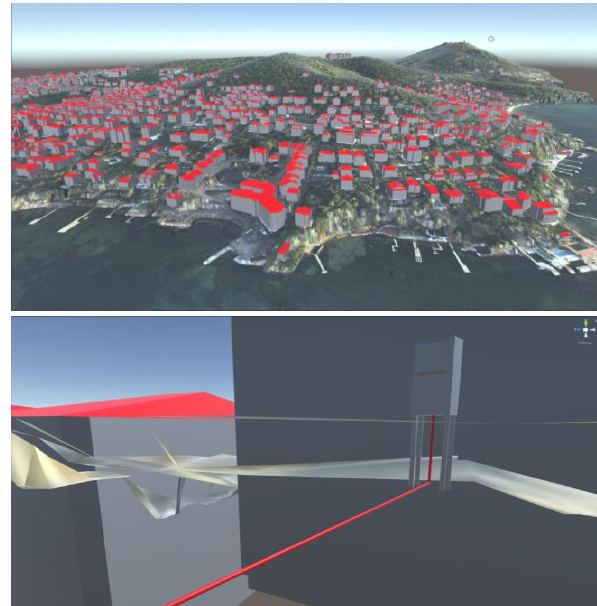
Figure 16. Example of utility mapping by BIMTAS company.